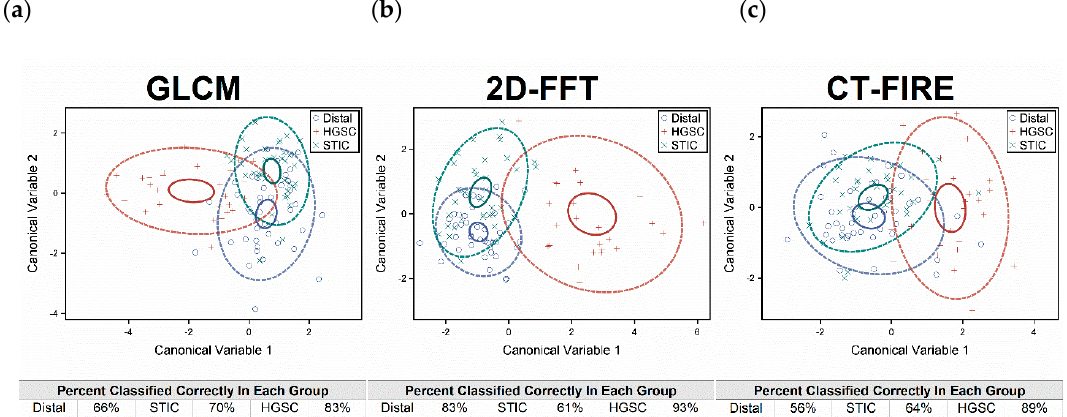
Figure 9. A. The CANDISC and DISCRIM results from each image analysis separately, where ( a ) is GLCM, ( b ) 2D-FFT, and ( c ) CT-FIRE results.